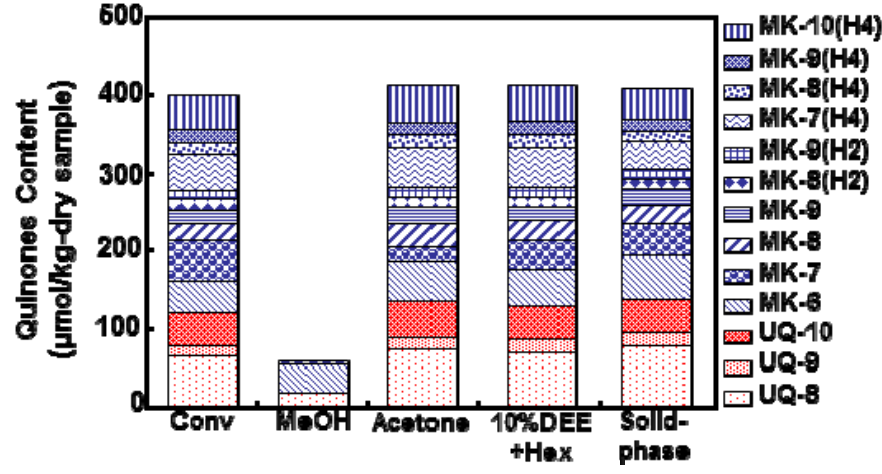
Figure 3. Effect of trapping system on the total content of the extracted quinones; conventional method (Conv); solvent trapping using methanol (MeOH); solvent trapping using acetone (acetone); solvent trapping using a mixture of 10% diethyl ether and hexane (10% DEE/Hex); solid trapping using Sep-Pak cartridge (solid-phase) (n =